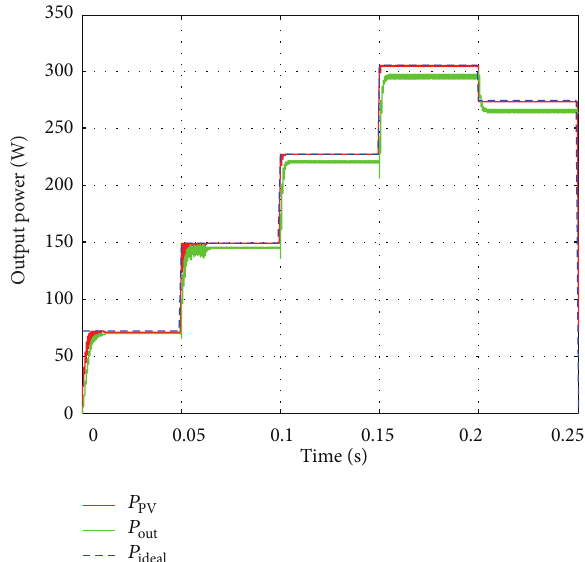
Figure 16: Output power of the PV and boost converter under variable irradiance.